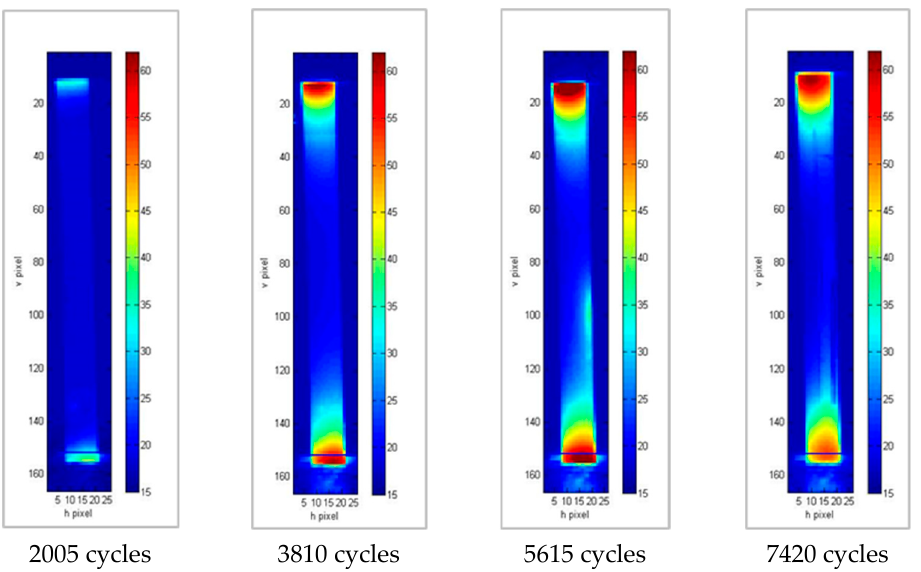
Figure 9. Thermograms at different loading cycles for specimen 8b.